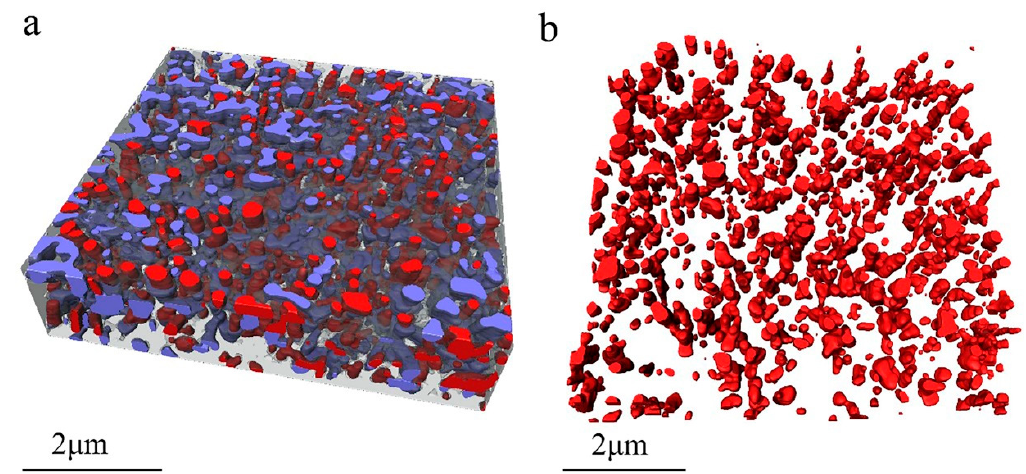
Figure 2. 3D rendering images of the sample: ( a ) 3D rendering of the acquired paint volume containing TiO 2 particles; ( b ) 3D spatial distribution of the TiO 2 particles only. The translucent grey parts are acrylic resin, the red parts are TiO 2 particles, and the blue parts are voids.